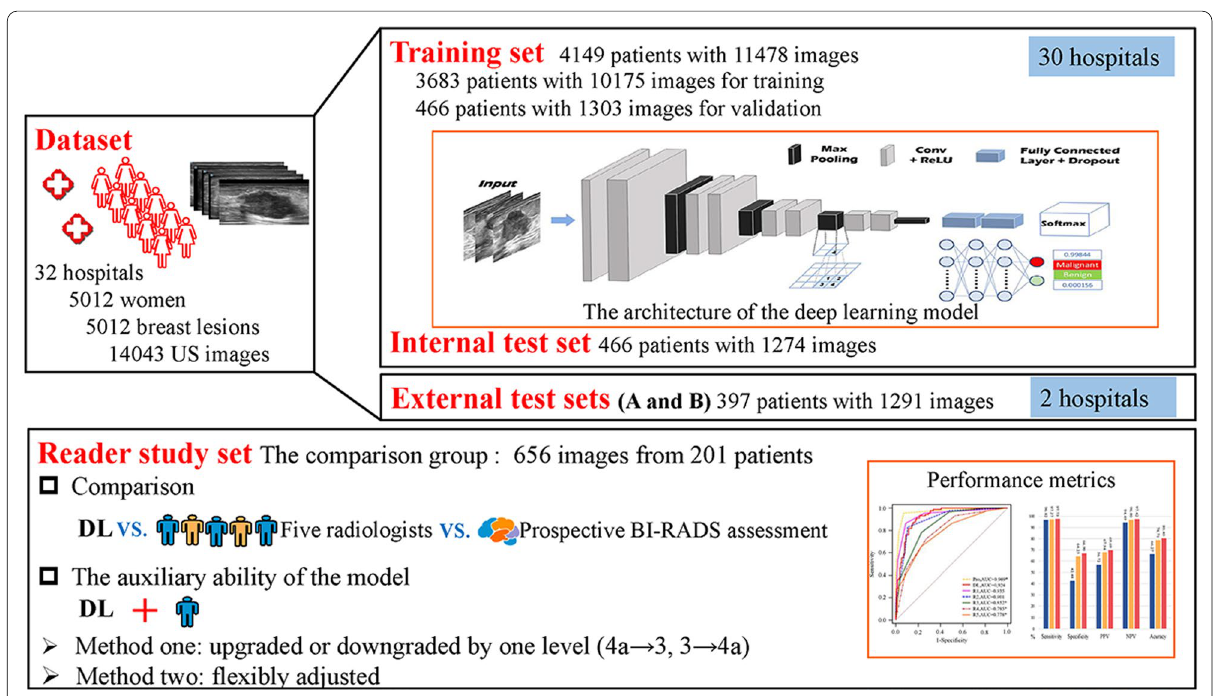
Fig. 1 Study workflow. US Ultrasound; Conv Convolutional Layer; ReLU Rectified Linear Unit; DL deep learning; BI-RADS Breast Imaging Reporting and Data